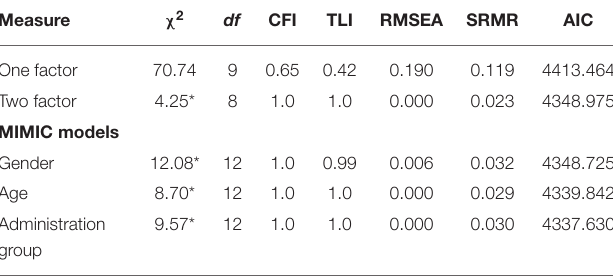
TABLE 7 | Fit indices for alternative 6-item